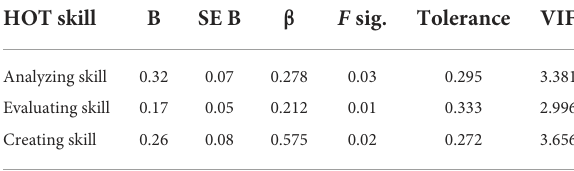
TABLE 8 Regression analysis of HOTS levels and reading